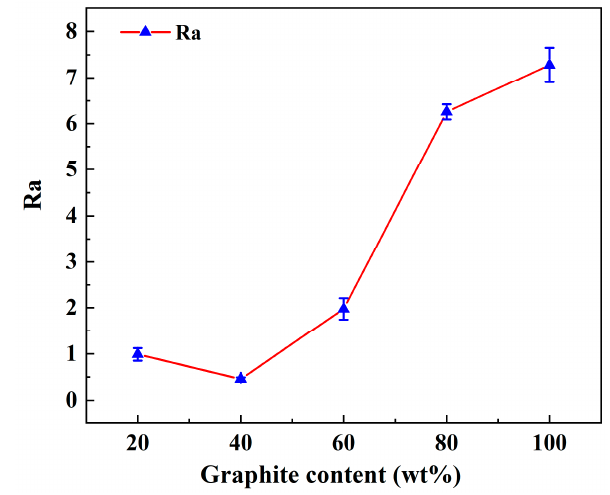
Figure 2. Variation in coating roughness with graphite content.